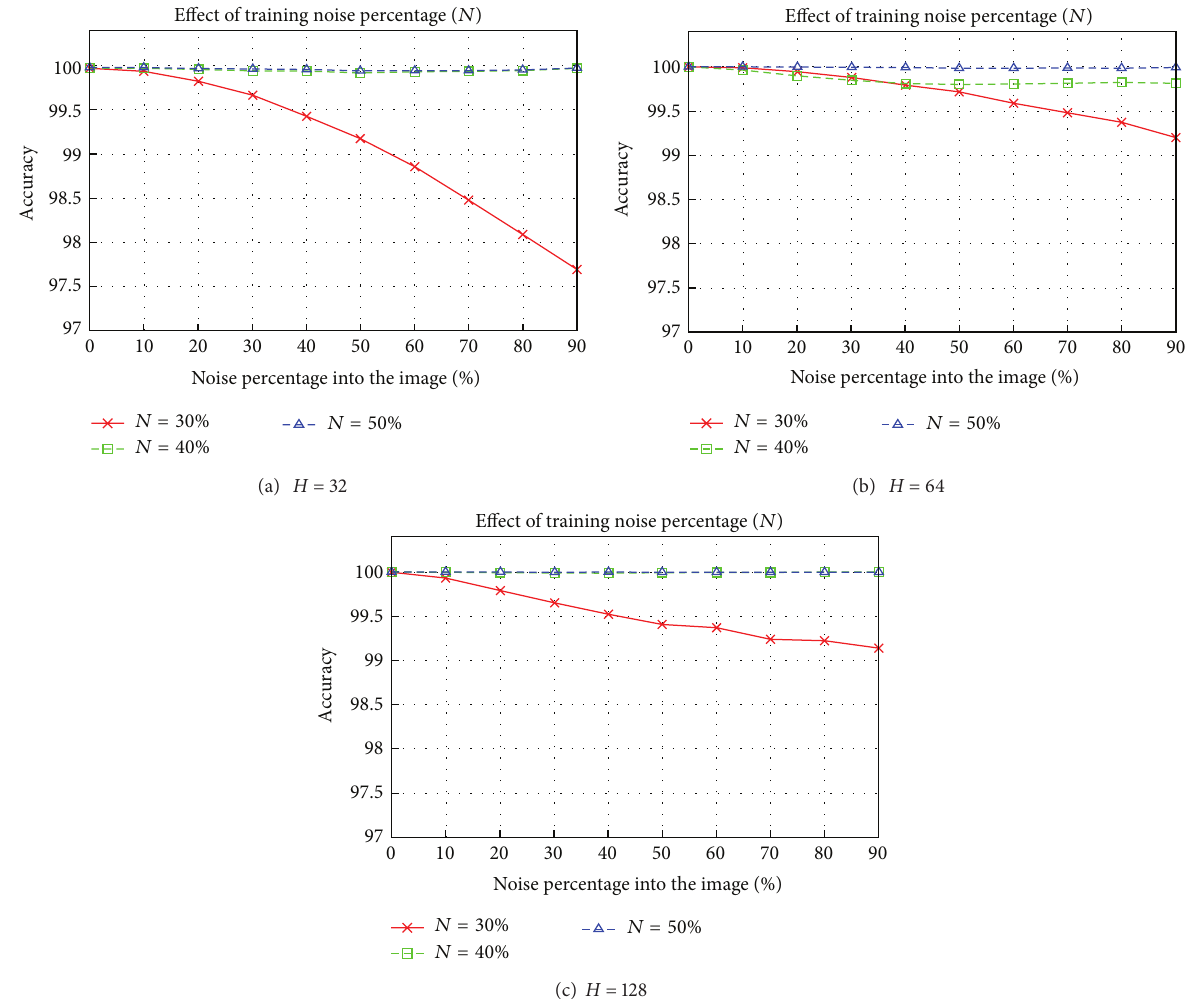
Figure 7: Noise detection results for different noise ratios using the Lenna image. The results are presented for different training image sizes.